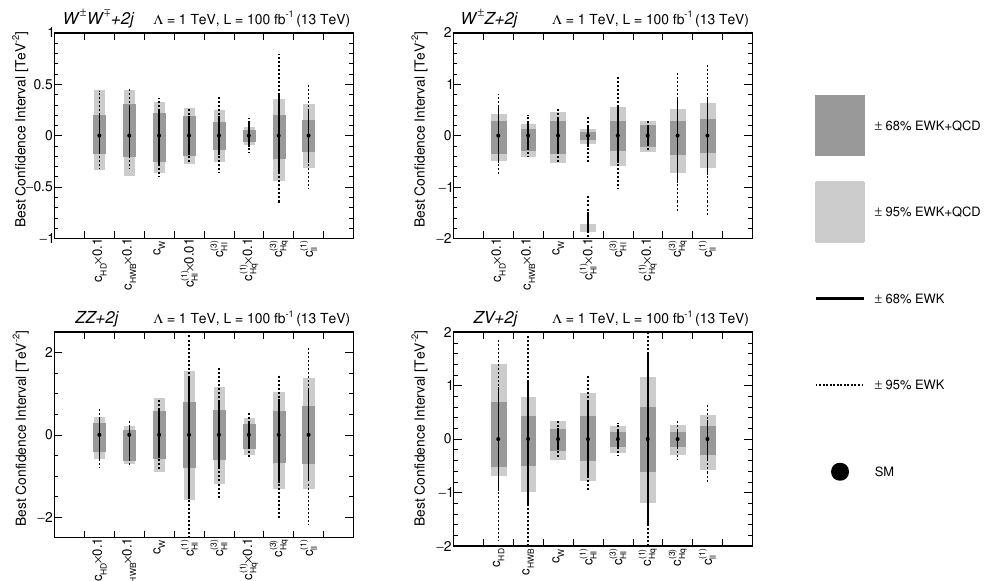
Figure 6 . Impact of EFT corrections to the QCD backgrounds on the fit sensitivity, for the channels OSWW+2j (upper left), WZ+2j (upper right), ZZ+2j (lower left) and ZV+2j (lower right). The black solid (dashed) lines represent the 68% c.l. (95% c.l.) expected limits obtained neglecting QCD EFT contributions. The dark (light) grey bands represent the 68% c.l. (95% c.l.) limits including the QCD EFT dependence in the fits. The black points correspond to the SM